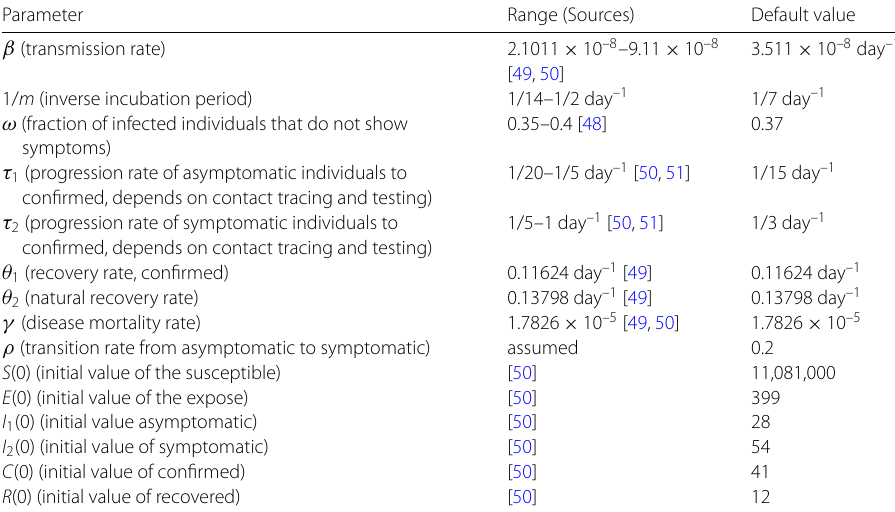
Table 1 Parameters of the disease model and their meanings Parameter Range (Sources) Default value β (transmission rate) 1/ m (inverse incubation